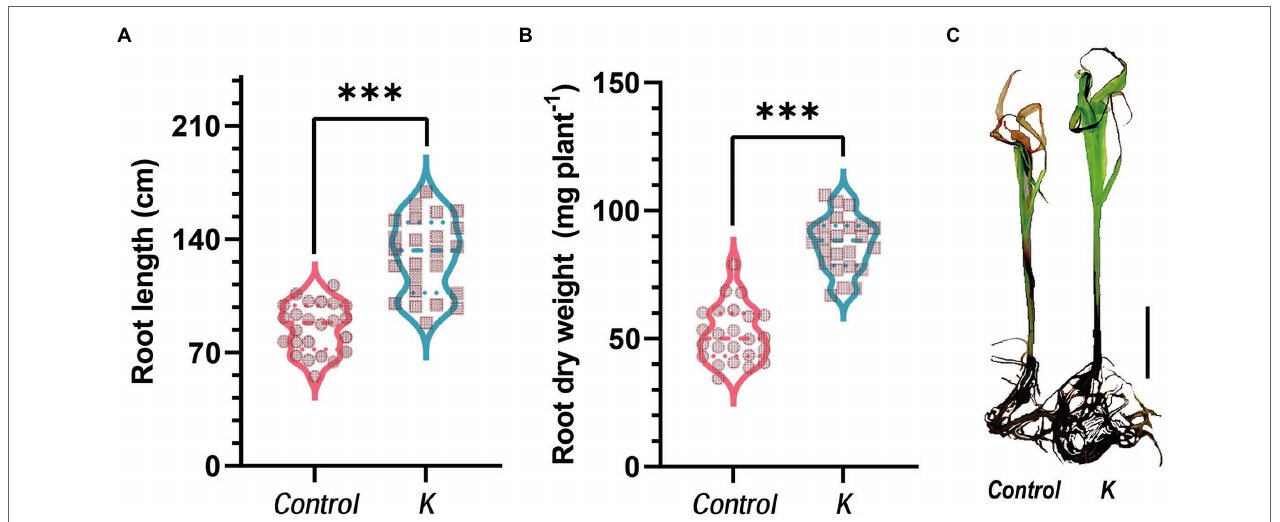
FIGURE 3 | Mucilaginibacter sp. K improves maize growth in salt stress. Violin plot showing strain K effects on root length (A) and root dry weight (B) of 28-day- old maize seedlings under salt stress (100 mM NaCl). Asterisks indicate the statistically significant differences compared to controls ( *** p < 0.001). (C) Morphological comparison of maize seedlings 28 days after growing in a glass tube experiment under gnotobiotic conditions with salt stress (initiated at day 14) in a growth chamber. Scale bar represents 5